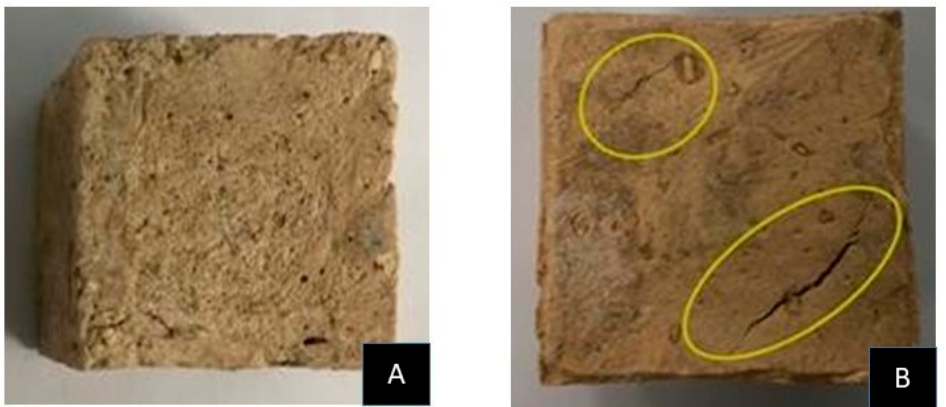
Figure 2. Physical observation of sintered kaolin-GGBS geopolymer.